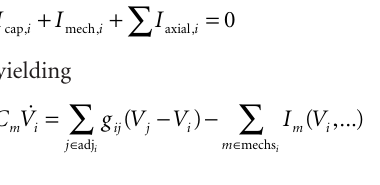
3 Electrical synapses/gap junctions can be modeled in a manner similar to the axial terms; however, this prohibits the usage of a highly optimized Gaussian elimination method presented in the next section. Therefore, we assume gap junctions to be modeled as mechanisms with the respective